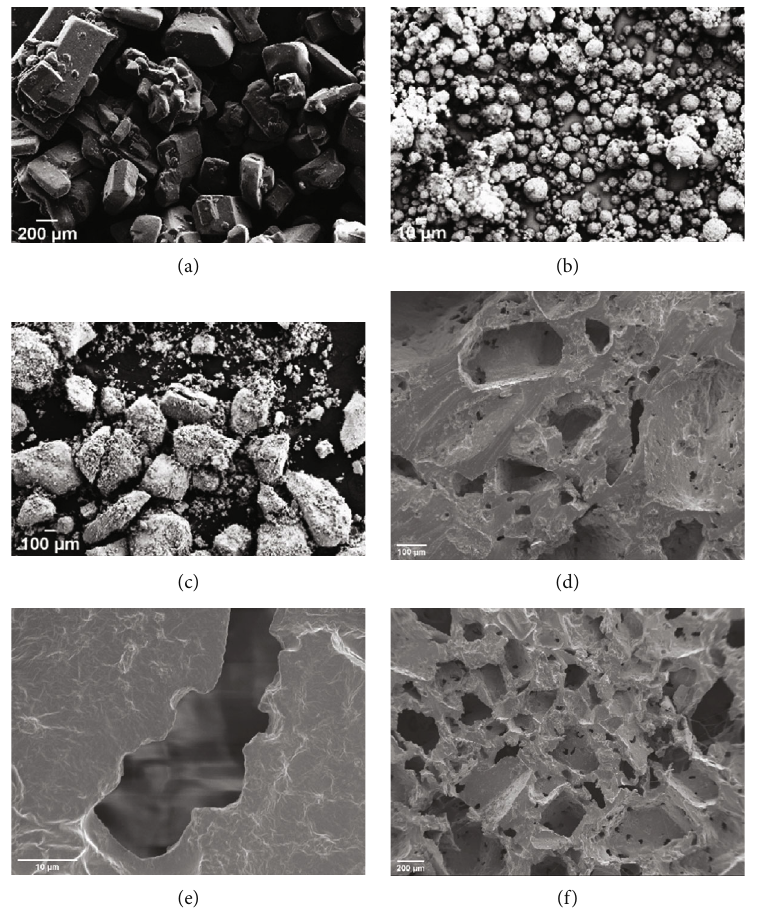
Figure 4: SEM images of (a) sugar particles, (b) bentonite particles, (c) magnetite particles, (d) PDMS, (e) PB, and (f) PBNP.